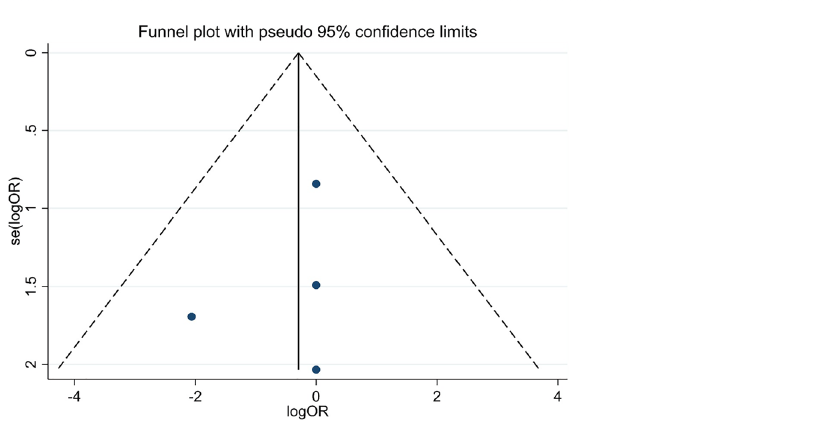
Figure 5. Funnel plot of studies assessing tumor recurrence of different treatment modalities in